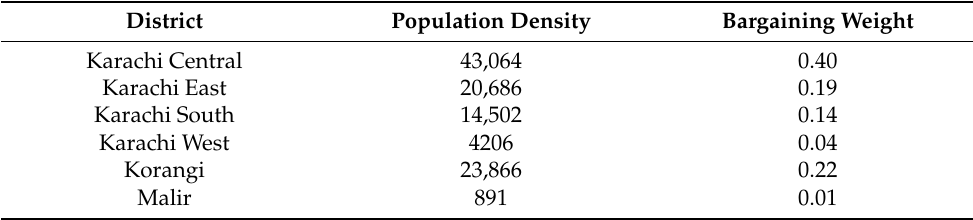
Table 1. Population densities and bargaining weights of all districts of